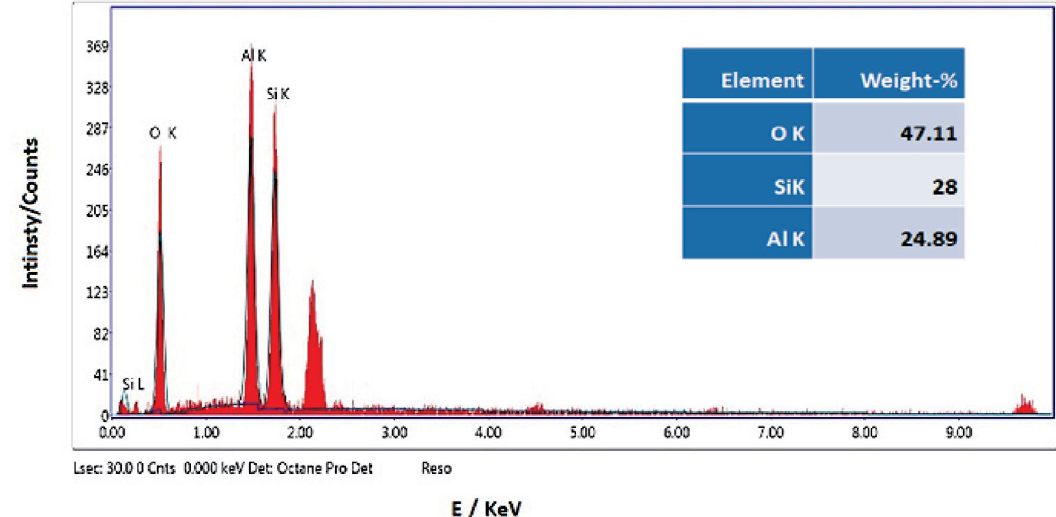
Figure 5. The EDX Microanalysis of mullite sample fired at 1000 °C.